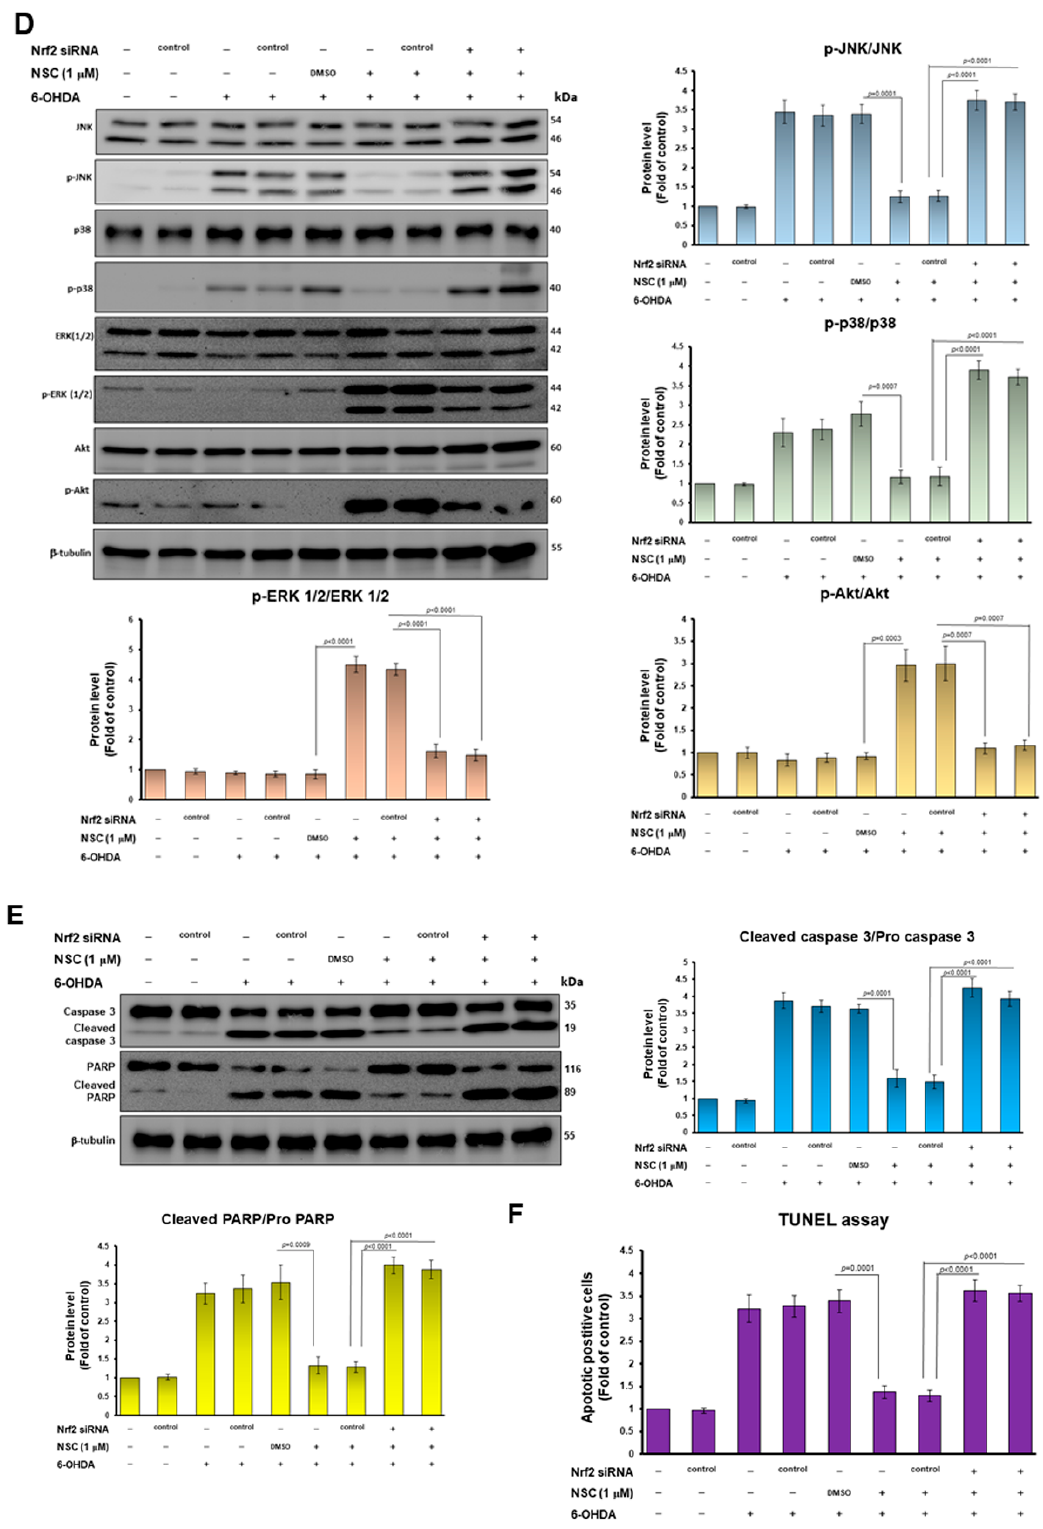
Figure 7. Downregulation of Nrf2 expression in the 6-OHDA-exposed SH-SY5Y cells abrogates the neuroprotective ability of narcissoside (NCS). SH-SY5Y cells were transfected with Nrf2 siRNA or control siRNA for 24 h. It was then pretreated with NCS for 24 h, followed by treatment with 6-OHDA for 6 h. ( A ) The levels of Nrf2, GCLC, and GCLM were analyzed by western blotting. The